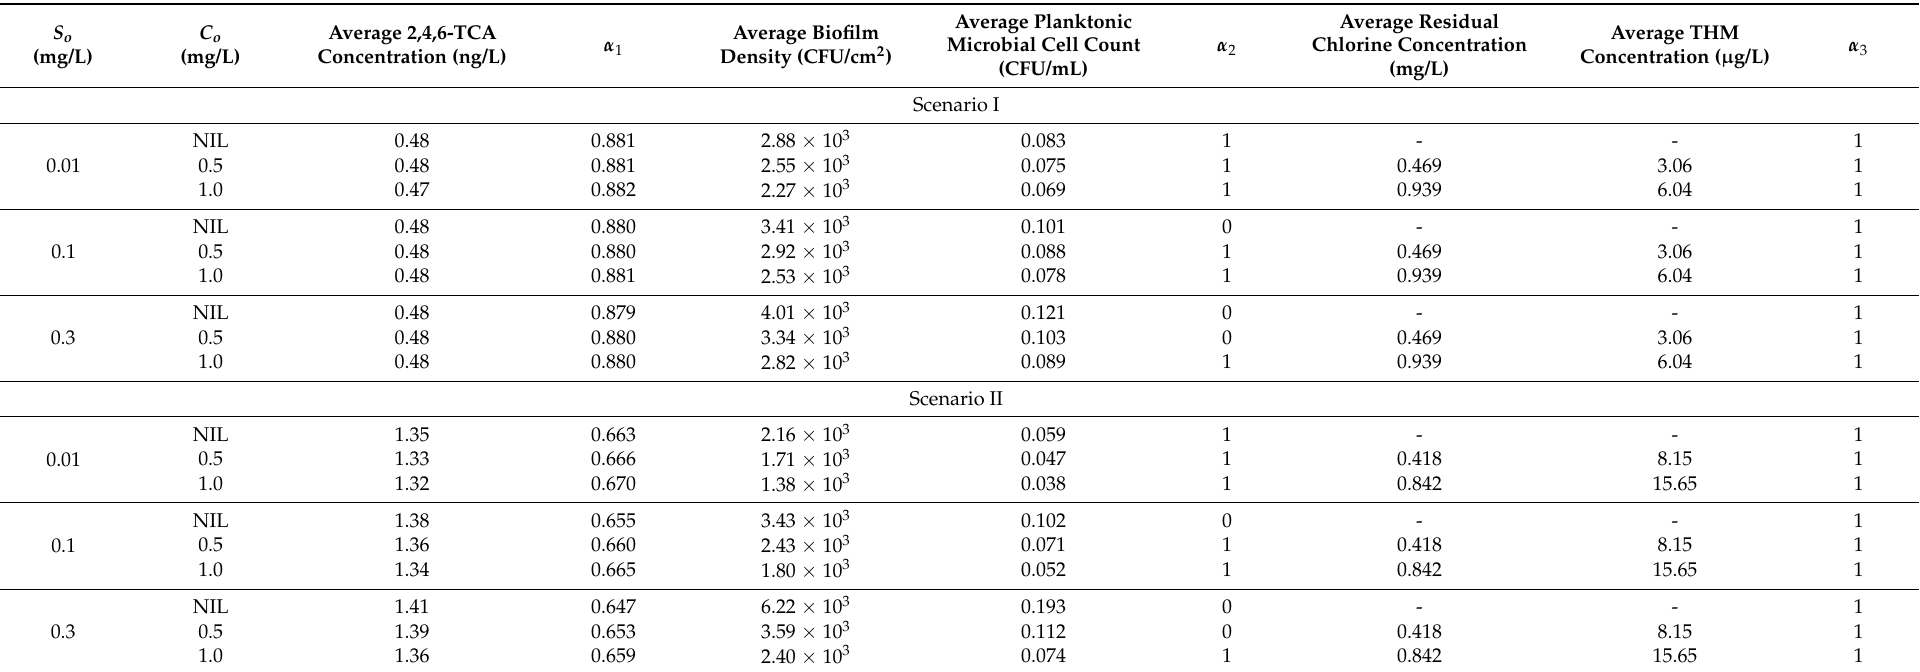
Table 5. Balerma network simulation results under T = 10 ◦ C and P o = 0.2